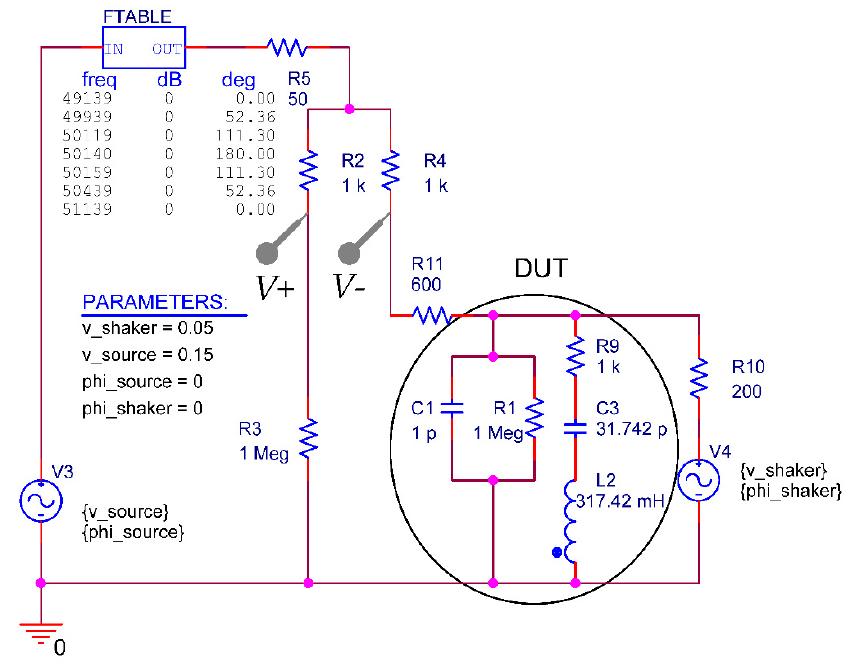
Figure 5. Equivalent circuit of the electrical circuit including the piezoelectric cantilever, the Wheatstone bridge and the shaker which includes the phase lag of the stimulating voltage at the integrated piezoelectric layer and the shaker impact. piezoelectric layer and the shaker